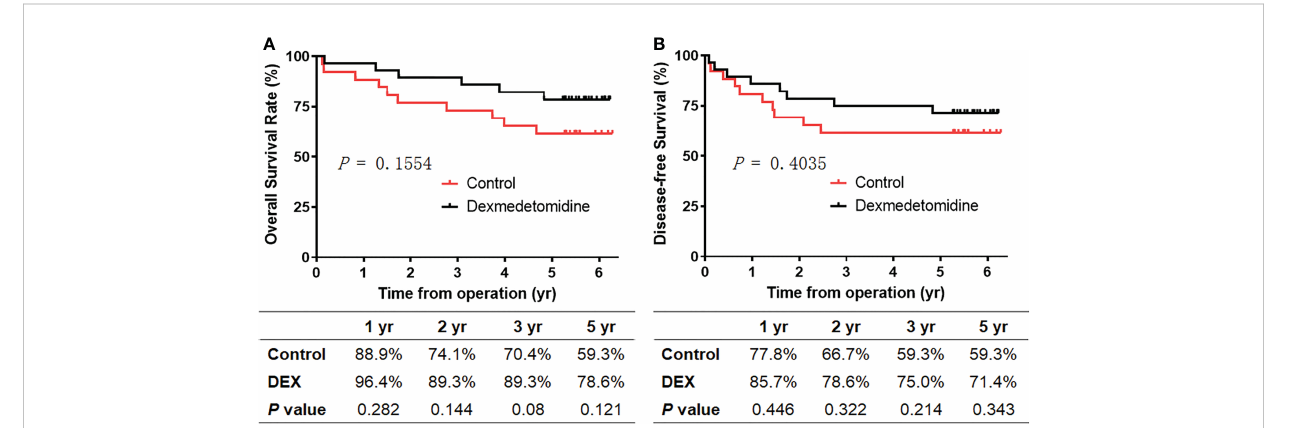
FIGURE 1 Survival of patients between the two groups. (A) Overall survival. (B) Disease-free survival. Kaplan – Meier curves showing overall survival and disease- free survival for patients receiving intraoperative dexmedetomidine (black line) or saline (red